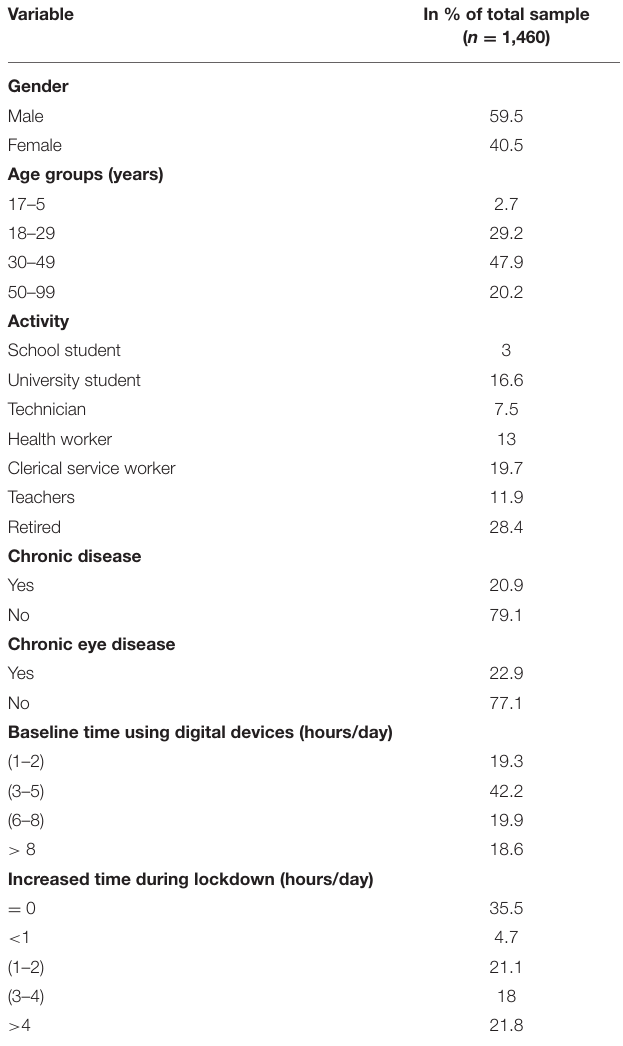
TABLE 1 | Descriptive statistics of the